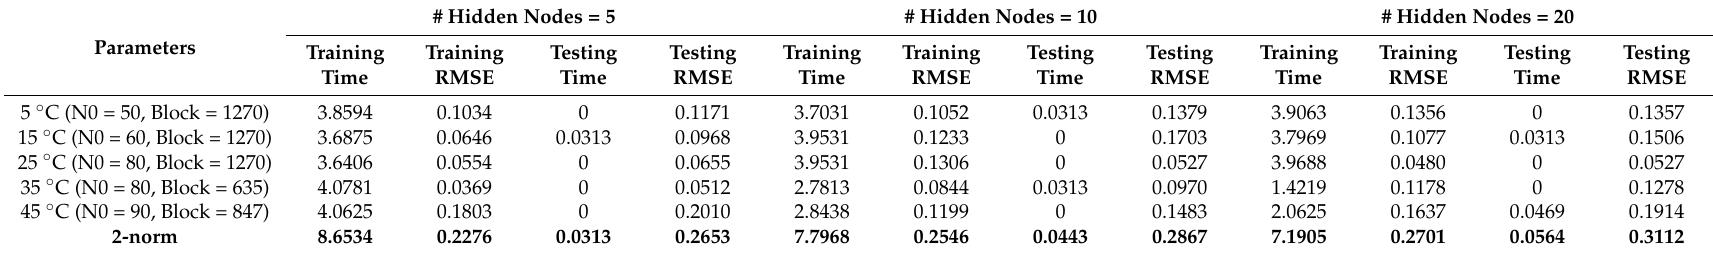
Table 9. Results of online sequential ELM with radial basis function (Number of initial training data used, N0 = 80; size of block of data learned in each step, Block = 1270).